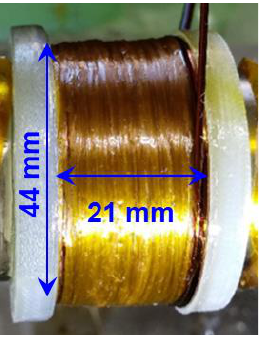
Figure 1. Photograph of the coil.